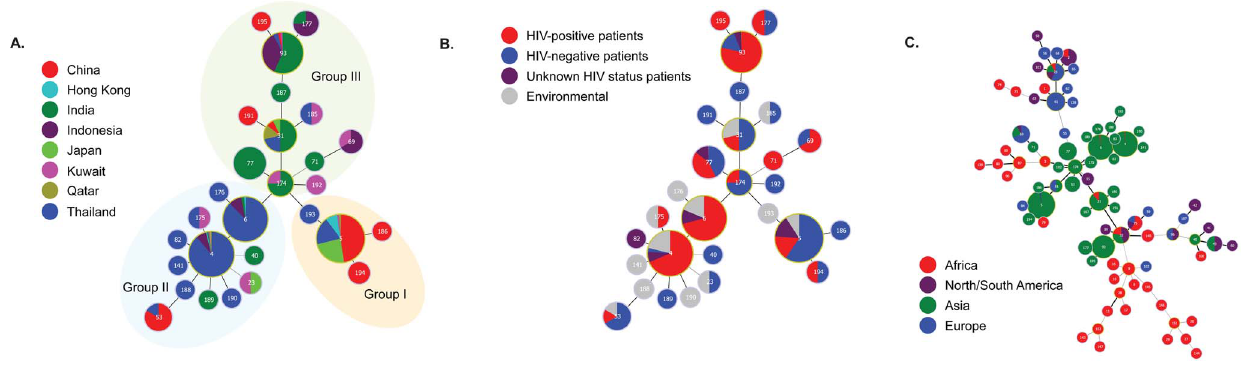
Figure 1. Minimum spanning trees using the goeBURST algorithm showing MLST relationships among Asian C. neoformans var. grubii isolates. (A) Tree represents 476 C . neoformans var. grubii isolates from different countries. Each circle represents a unique genotype/ sequence type (STs). The size of the circle corresponds to the number of isolates within that genotype. Different colors correspond to different countries; (B) Same as A, but now showing the genotypes from clinical and environmental sources; (C) Same as A and B, but with the addition of the genotypes of 179 C . neoformans var. grubii isolates from different continents (data from http://mlst.mycologylab.org and previous reports by Cogliati et al ., 2013 [44] and Mihara et al ., 2012 [16]).